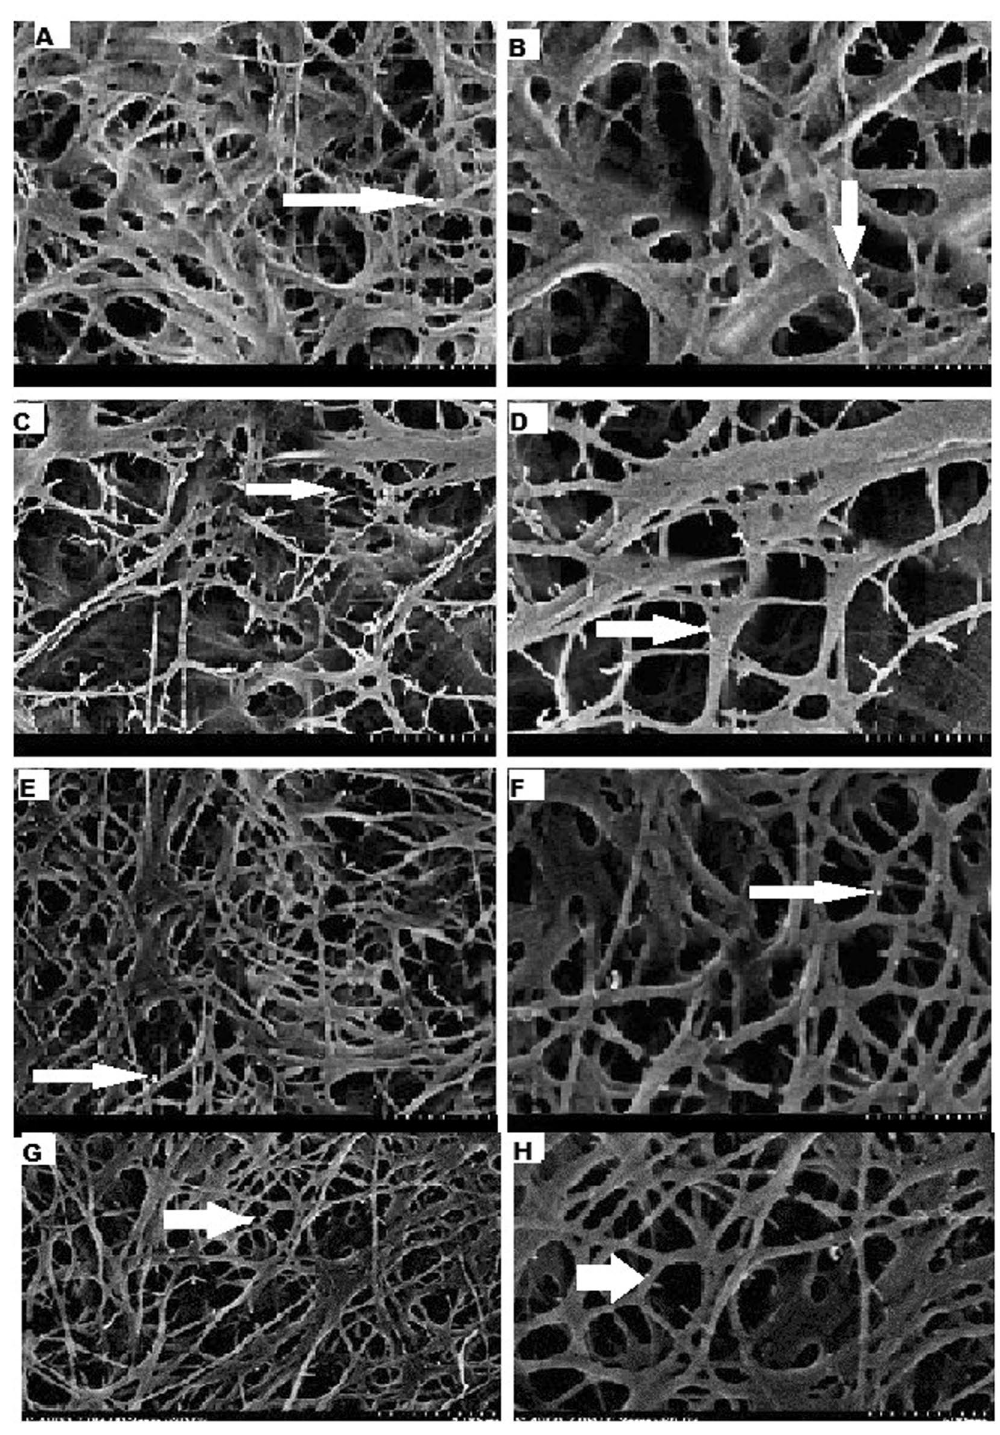
Figure 1. Field Emission Scanning Electron Microscopic images of the Etching groups. ( A ) COE images: Collagen fibrils are suspended in the mesh form, 3D reticular structures; gold immune labeling was not depicted without demineralization. ( B ) Amplification of COE images: 3D Collagen network more clearly seen and gold nano-particles evident. ( C ) CHE images: Visible easily depicted major form of collagen structures, Exposed collagen in the mesh form with Gold nano-particles in the secondary fibers. ( D ) Amplification of CHE images: 3D collagen fibrils clearly evident with numerous gold immunolabeling as white dots. ( E ) DOE images: Depicted of collagen structures, Exposed collagen in the mesh form with Gold nanoparticles in the secondary fibers. ( F ) Amplification of DOE images: 3D collagen fibrils clearly evident with numerous gold immunolabeling as white dots. ( G ) PAE images: Collagen fibrils are suspended in the mesh form, 3D reticular structures; Gold immunelabeling was less depicted without demineralization. ( H ) Amplification of PAE images: 3D collagen fibrils clearly evident with gold immunolabeling as white